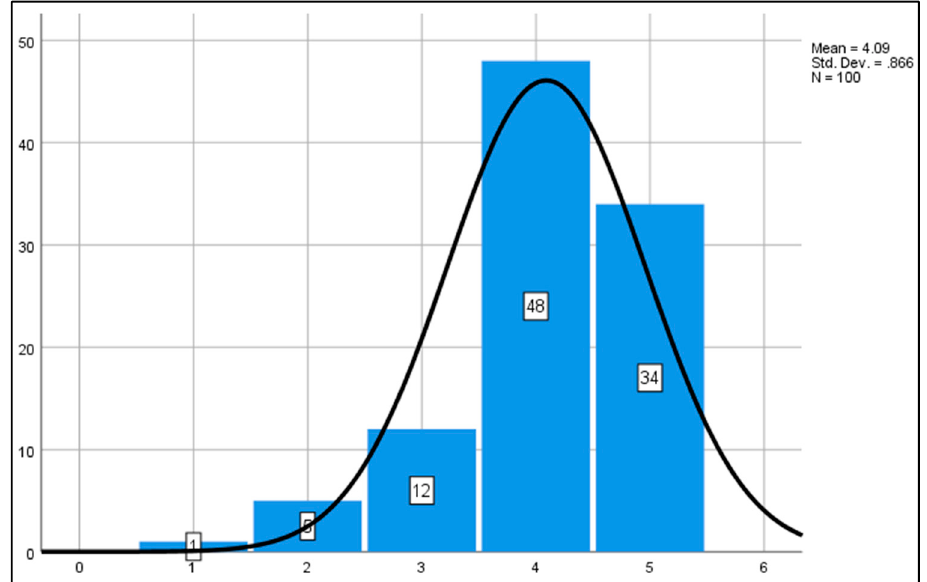
Figure 9 . Knowledge and Industry 4.0 readiness.